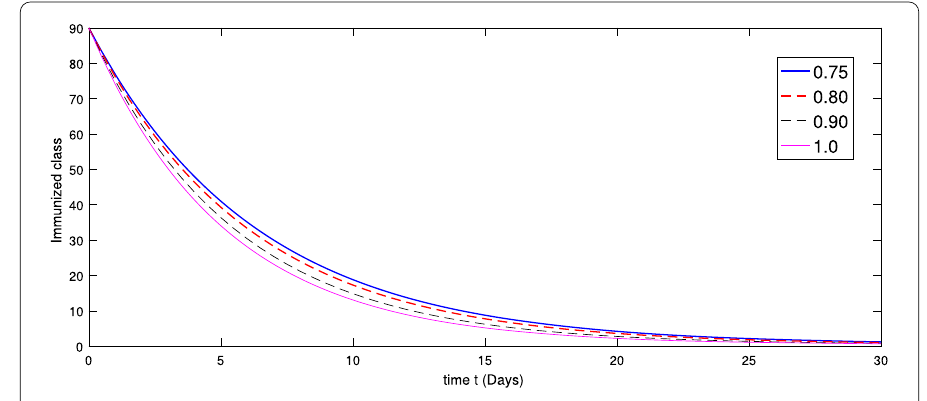
Figure 2 Graphical representation of approximate solutions up to five terms of immunized population M ( t ) at different fractional order of the considered model